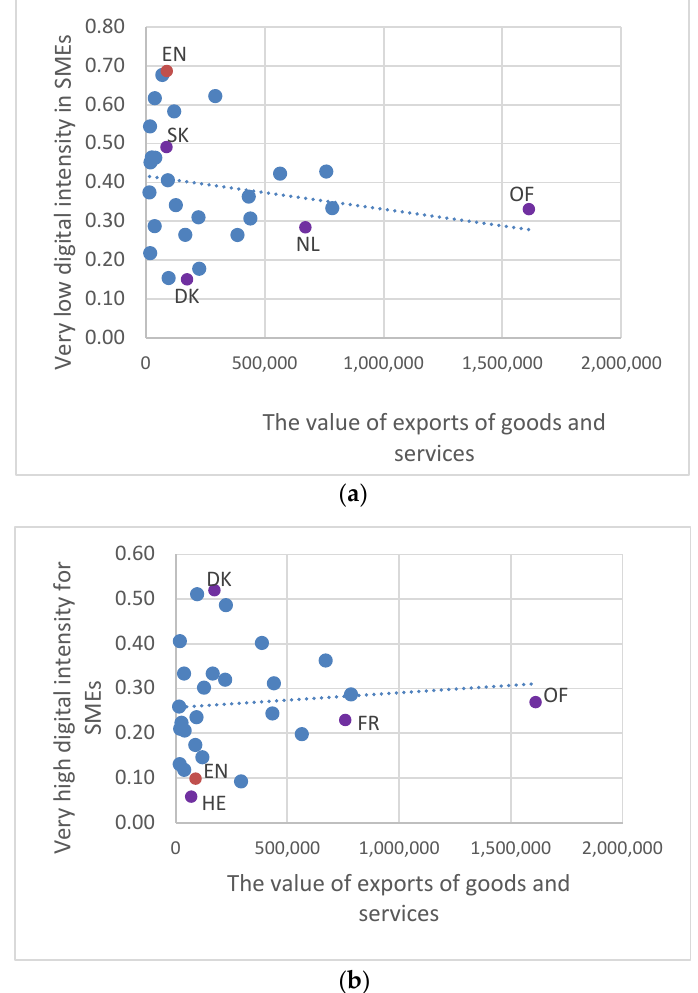
Figure 8. The relationship between digital intensity for SMEs and EU exports in 2019. ( a ) The value of exports of goods and services for very low digital intensity in SMEs. ( b ) The value of exports of goods and services for very high digital intensity in SMEs.